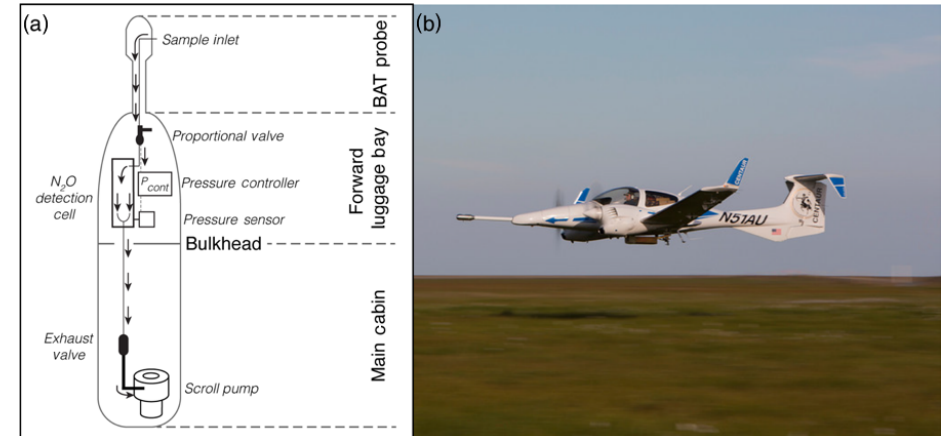
Figure 1. FOCAL during flight. (a) Top-down schematic of the atmospheric gas flow through the aircraft (not to scale). The sample inlet is situated on the BAT probe, located at the nose of the plane. The gas is pumped through the pressure-regulated detection cell of the ICOS spectrometer, located within the luggage bay in front of the pilot. (b) Image of the Diamond DA42 flying around 15 m above the surface.